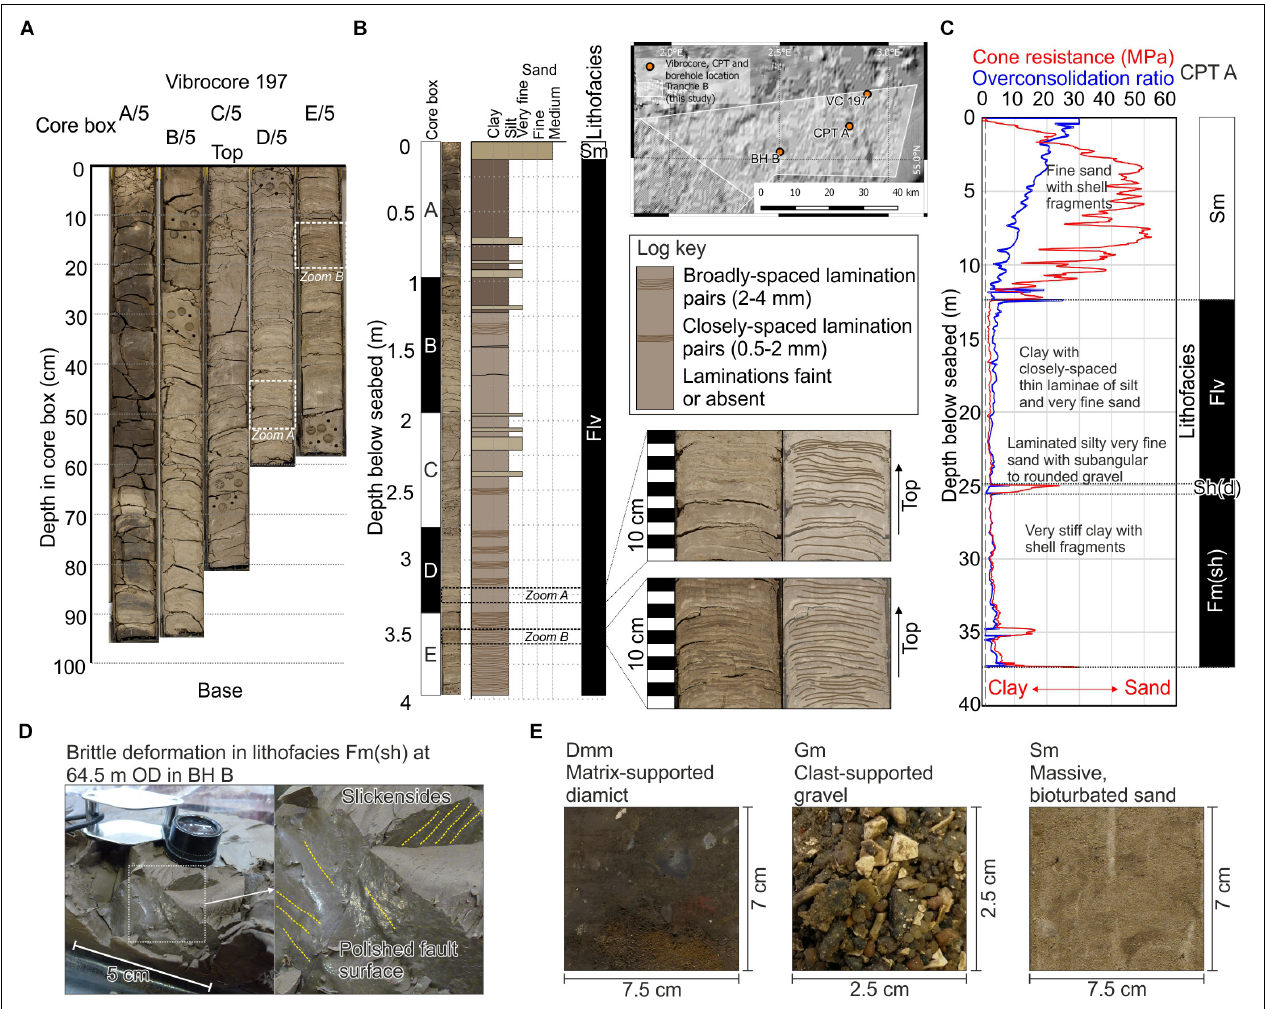
FIGURE 2 | (A) Photograph of vibrocore 197 and (B) its sedimentary log with interpreted lithofacies, showing proglacial lake clay and silt rhythmites interpreted to be varves. Vibrocore 197 acquired June 1983, photograph date August 2017. (C) Log of Cone Penetration Test (CPT) A showing cone resistance plotted against depth. Low cone resistance represents clay (generally low friction) and high cone resistance represents sand (generally high friction). (D) Photograph of a short core section of borehole BH B showing brittle deformation in lithofacies Fm(sh). (E) Representative photographs of lithofacies Dmm (matrix-supported diamict), Gm (clast-supported gravel), and Sm (massive, bioturbated sand). For lithofacies descriptions see Table 4